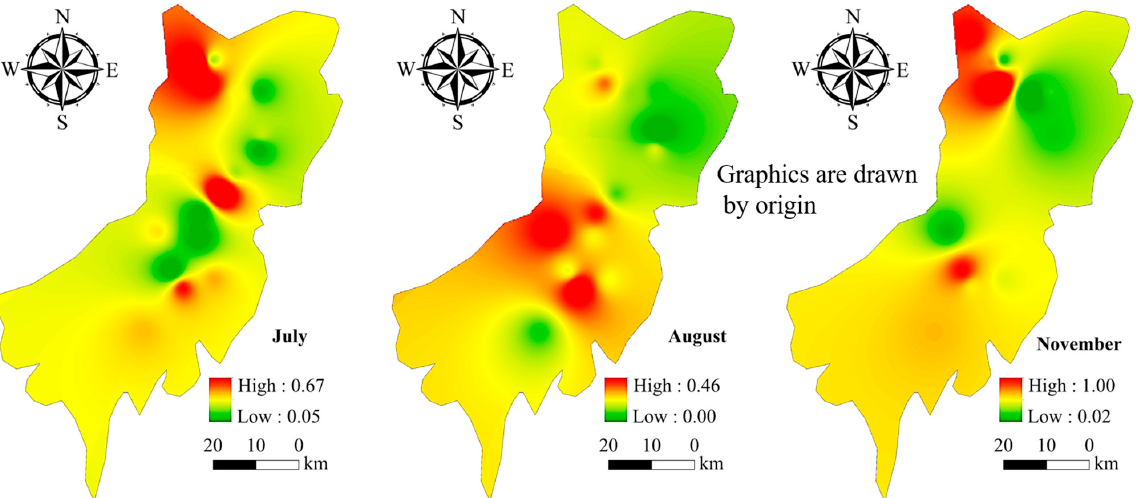
Figure 9. Spatiotemporal characteristics of water quality in the Maotiao River Basin (Gizhou province, SW China) in 2020 based on the VIKOR model.